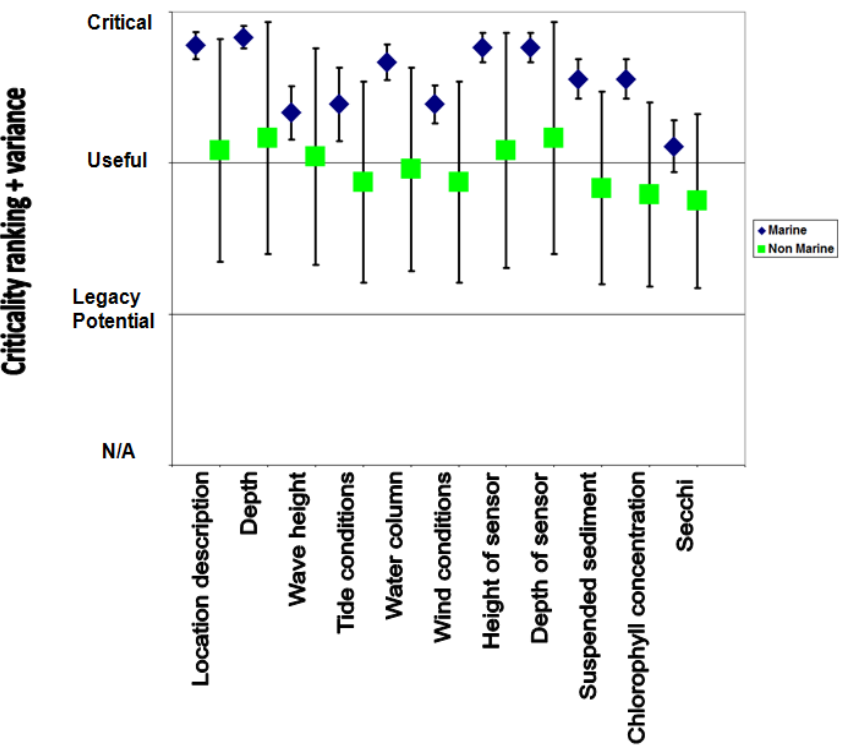
= 18, Non Marine n = 1 2